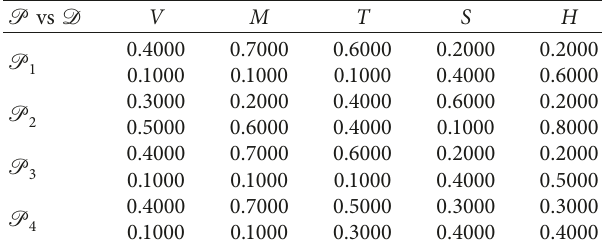
Table 4: MD and NMD for FFCR Δ ⌣ . P vs